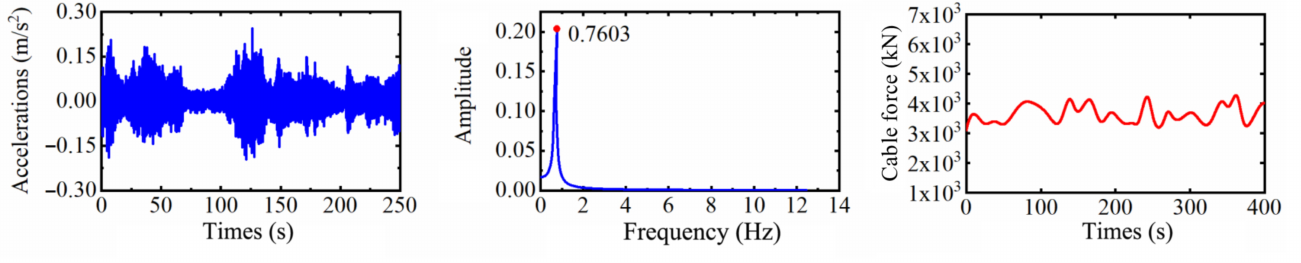
Figure 15. Acceleration signal, vibration spectrum and time-varying force of the A15 cable in the time interval of 10:10–10:20 on 11 October